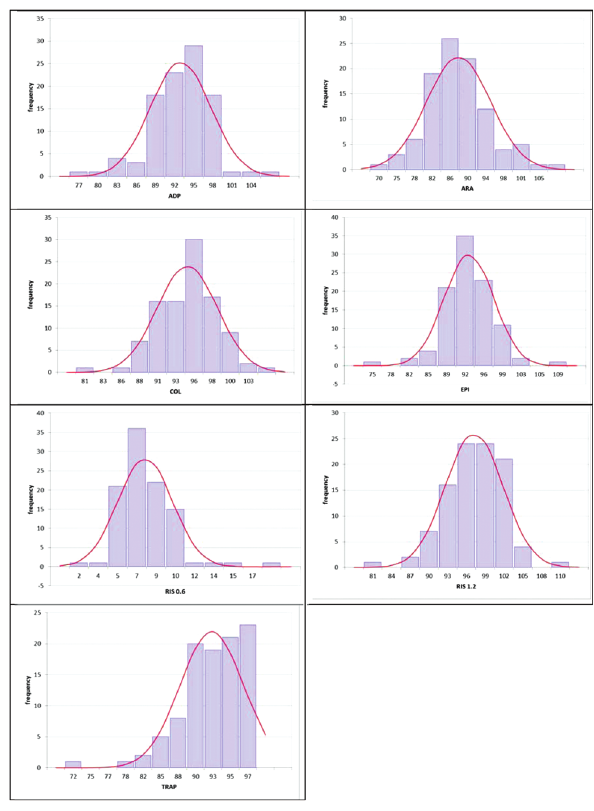
Fig. 2 Normal range distribution histograms (TXRA, MA%). The distribution of MA% values obtained onTXRA is shown for MA% for all reagents used in this